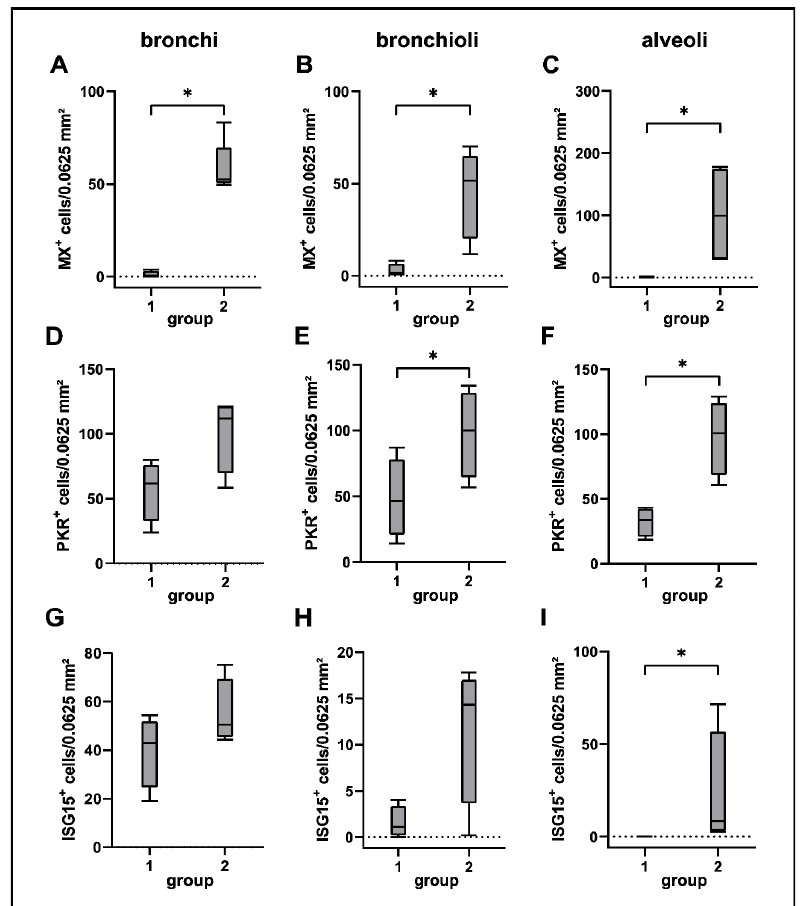
Figure 12. Quantification of Mx ( A – C ), PKR ( D – F ) and ISG15 ( G – I ) in lung tissue of canine distemper virus (CDV)-infected dogs. Groups: 1 = non-infected control lungs; 2 = acute CDV infection; box and whisker plots display median and quartiles with maximum and minimum values. Significant differences ( p ≤ 0.05, Kruskal–Wallis H test) are labelled by asterisks.